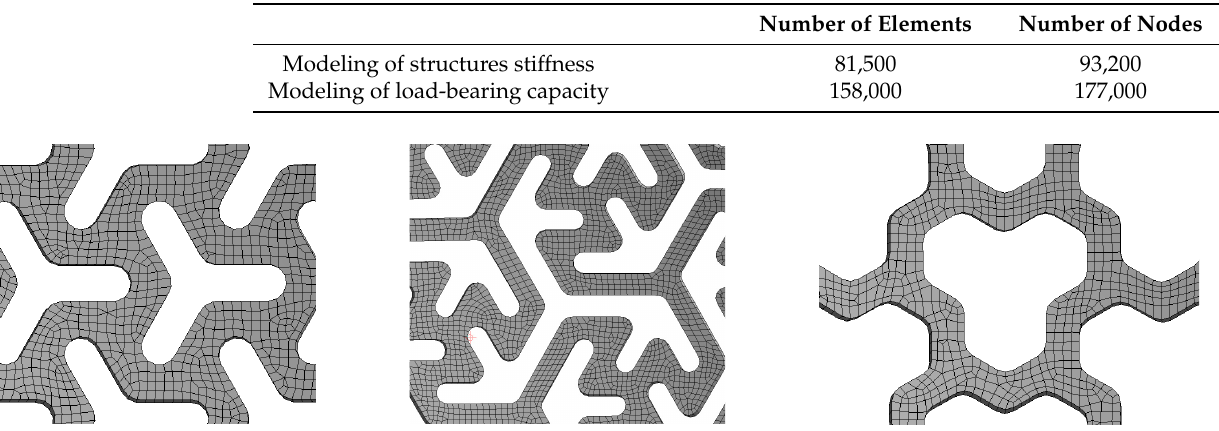
Table 3. Finite element mesh statistics.